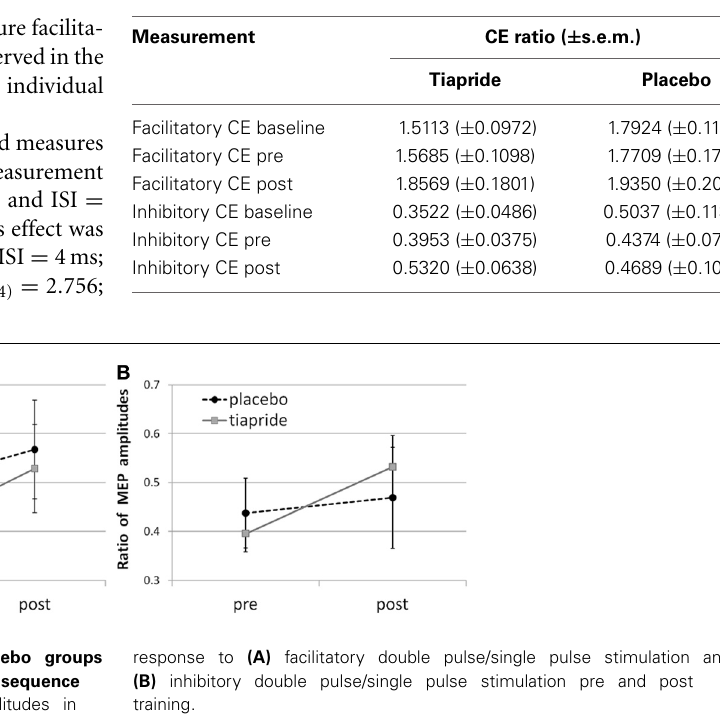
Table 1 | Cortical excitability baseline, pre and post training in tiapride, and control participants.